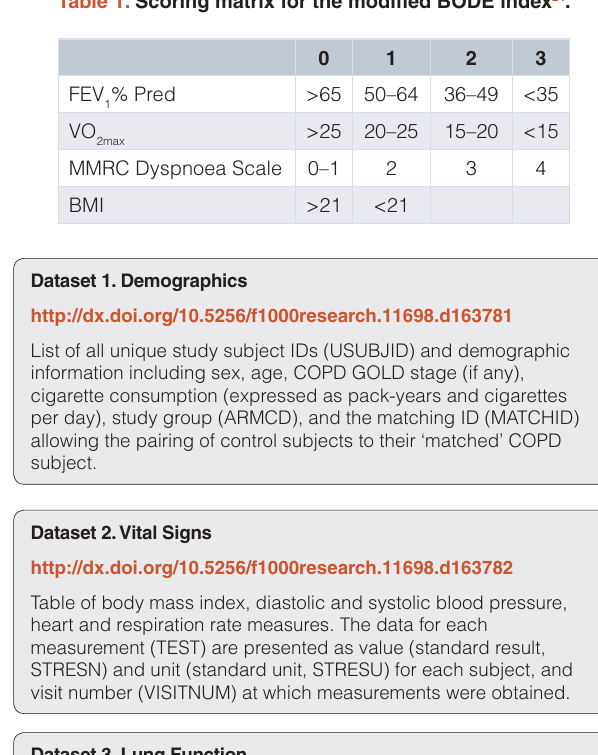
Table of lung function data for each subject, including percent predicted values for: